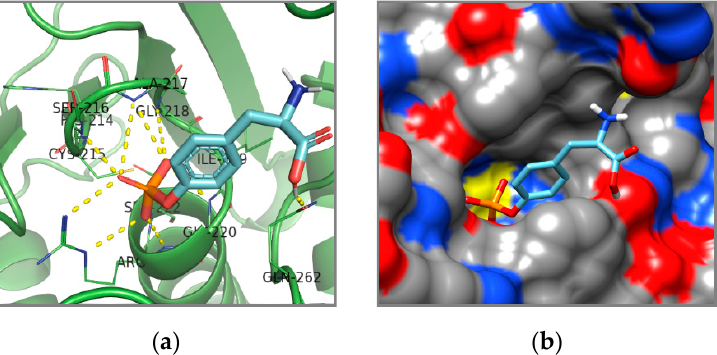
Figure 6. Docking result of phosphorylated tyrosine in the PTP1B catalytic site ( a ) Key residues; ( b ) Binding pose. The colors represent the element or atom (Red: Oxygen; Blue: Nitrogen; Yellow: Sulphur; White: Hydrogen; Orange: Phosphor; Green: Carbon of the receptor residues; Cyan: Carbon of ligand; Dotted Yellow line: Interaction between the atoms).